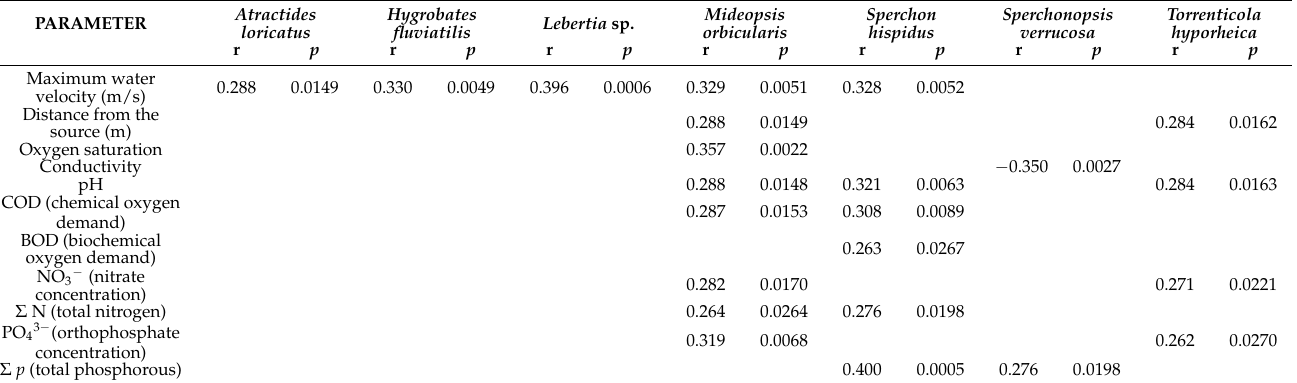
Table 4. Values of Spearman correlation coefficient (r) between environmental parameters and water mite species for which at least one statistically significant correlation was found. Only statistically relevant ( i = 12; p = 0.0271) correlations are